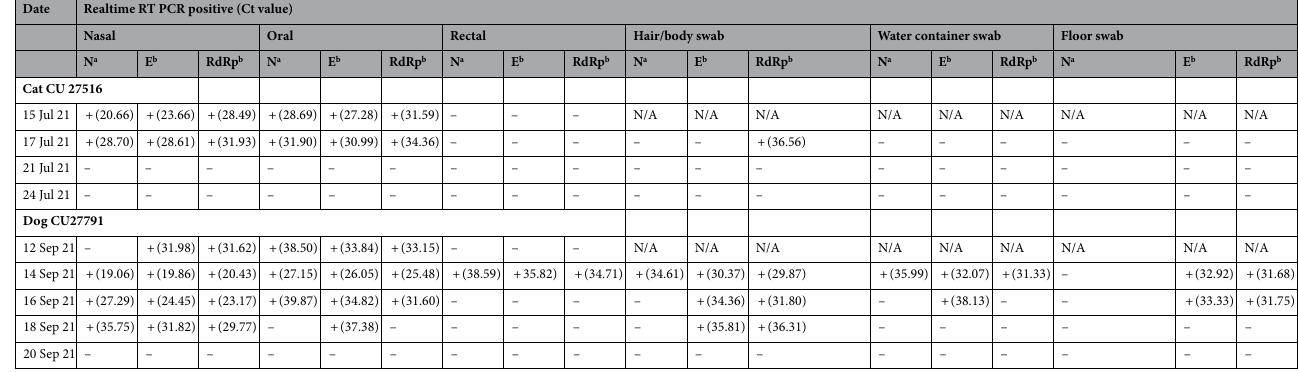
Table 3. Result of SARS-CoV-2 detection from cat and dog swab samples by realtime-RT-PCR. a Primers and